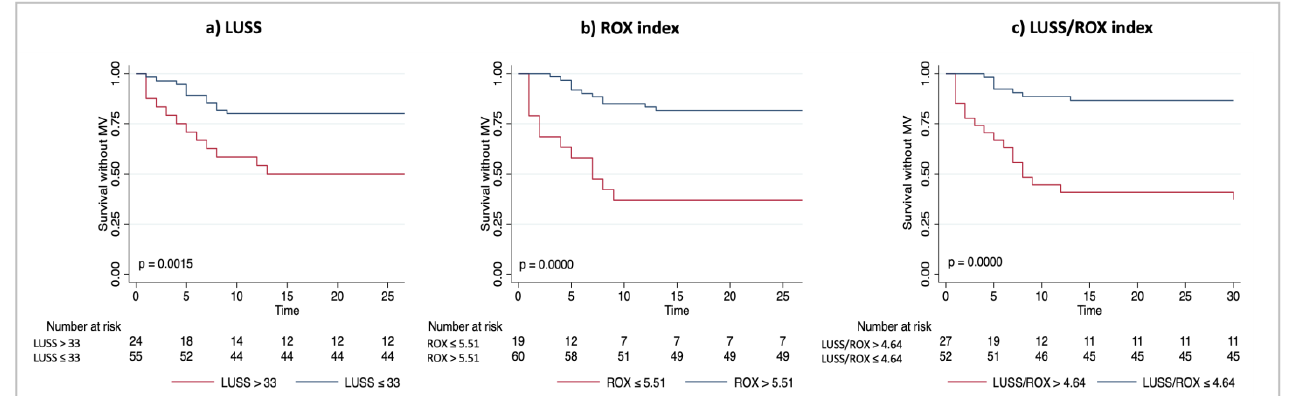
Figure 2. Unadjusted Kaplan – Meier plots showing the probability of survival without invasive mechanical ventilation according to LUSS ( a ), ROX index ( b ) and LUSS/ROX ( c ) stratified by their best cut-offs. Definition of abbreviations: MV: mechanical ventilation; LUSS: lung ultrasound score; ROX: respiratory rate – oxygenation. Differences between the stratified populations were assessed using log-rank test.